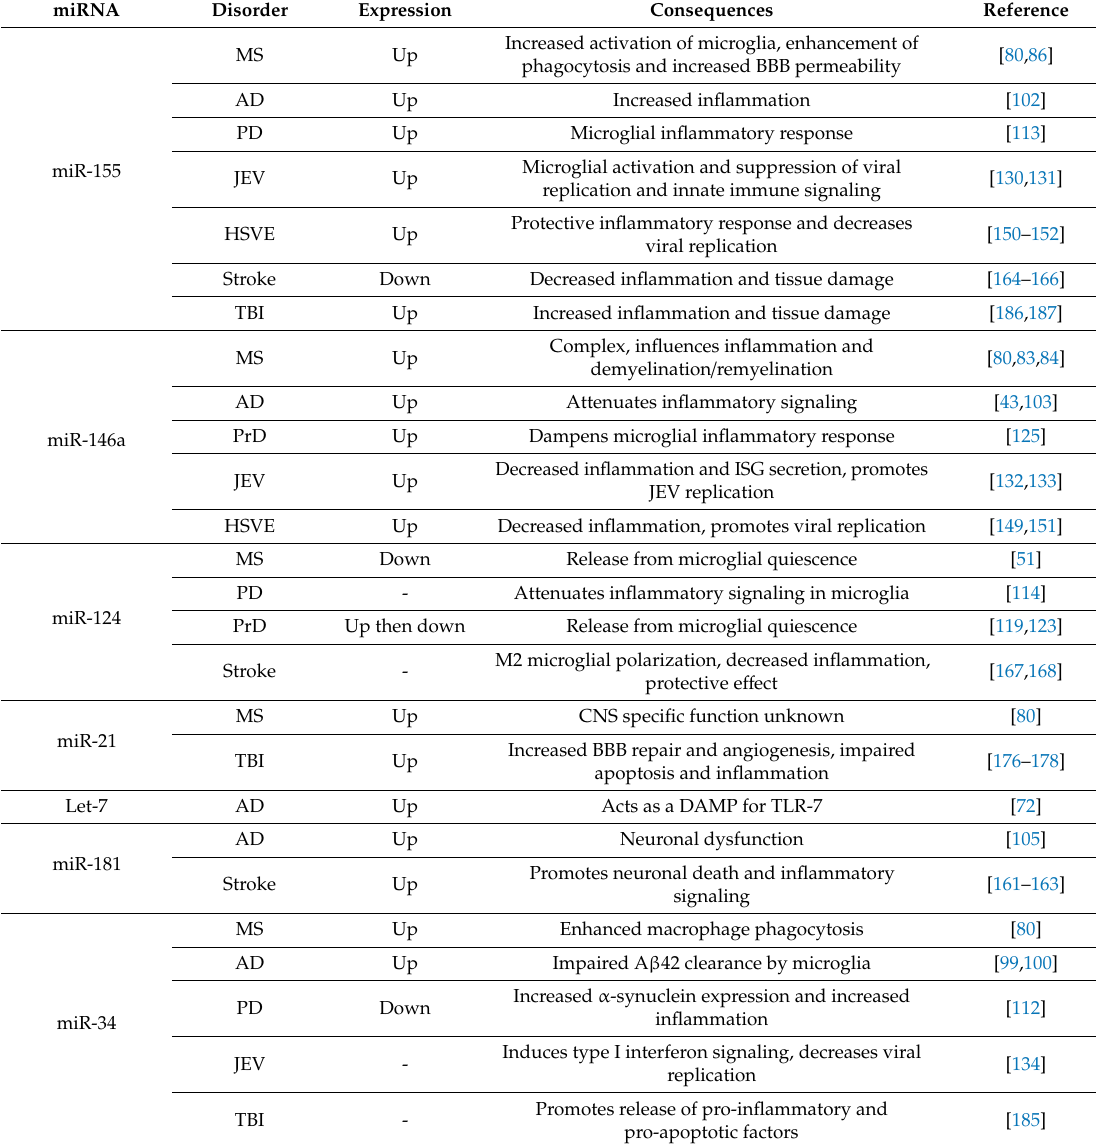
Table 1. Notable miRNAs in disorders of